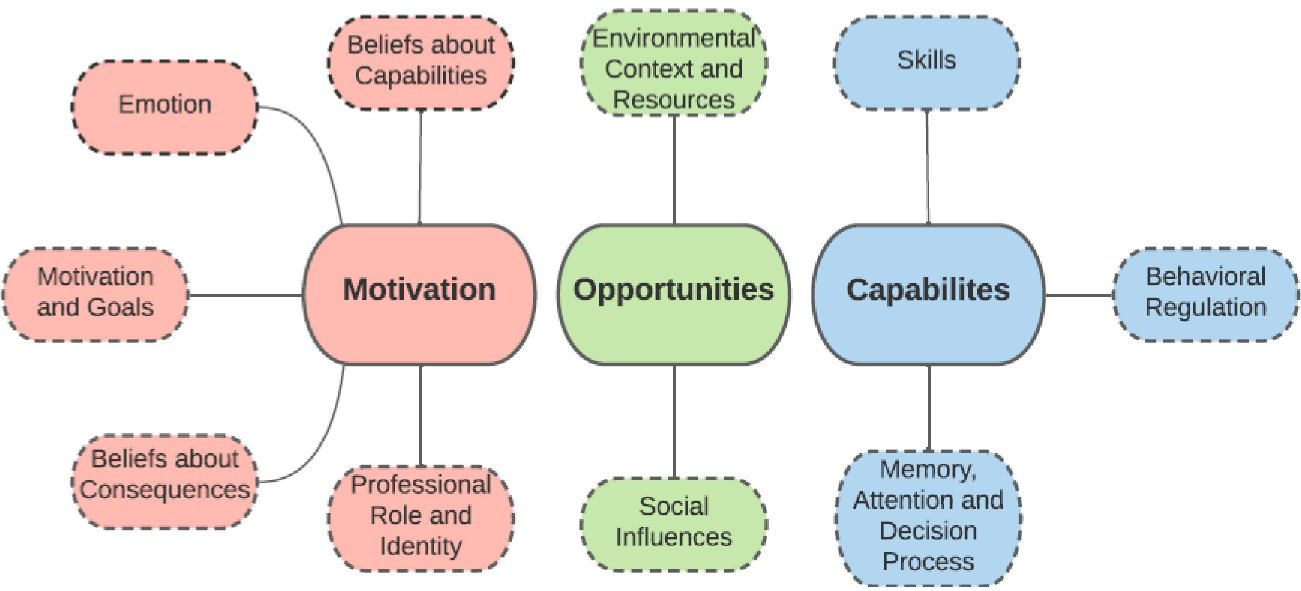
Fig 1. TDF domains analyzed under behavior change